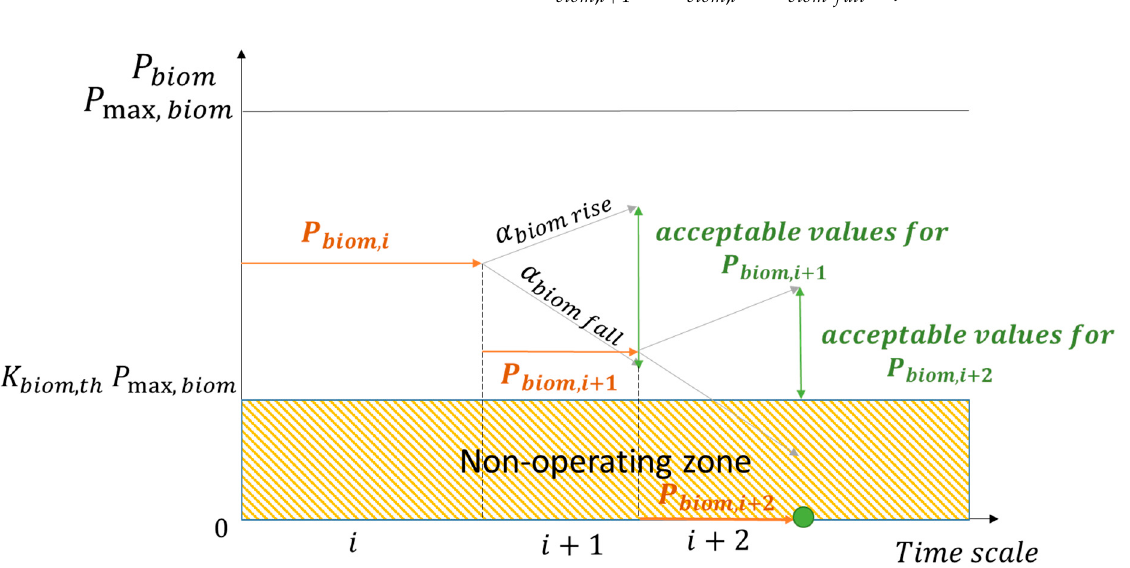
Figure 4. Representation of biomass power as a function of the time step.